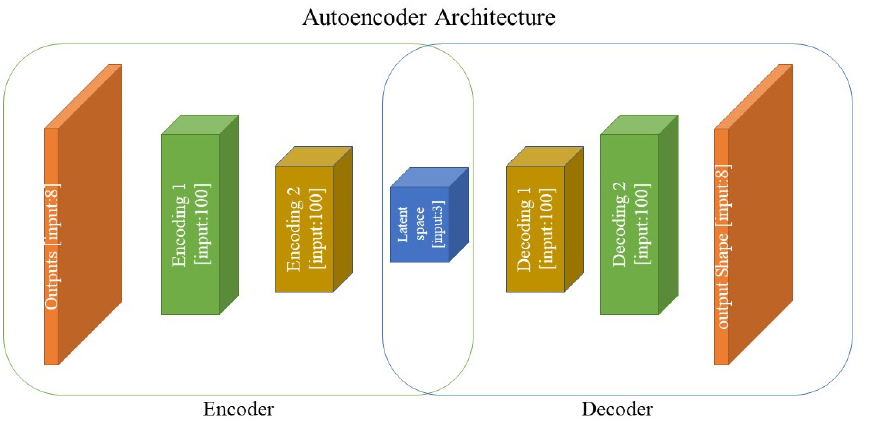
Figure 4. Modified autoencoder network architecture for fast material design and characterization.